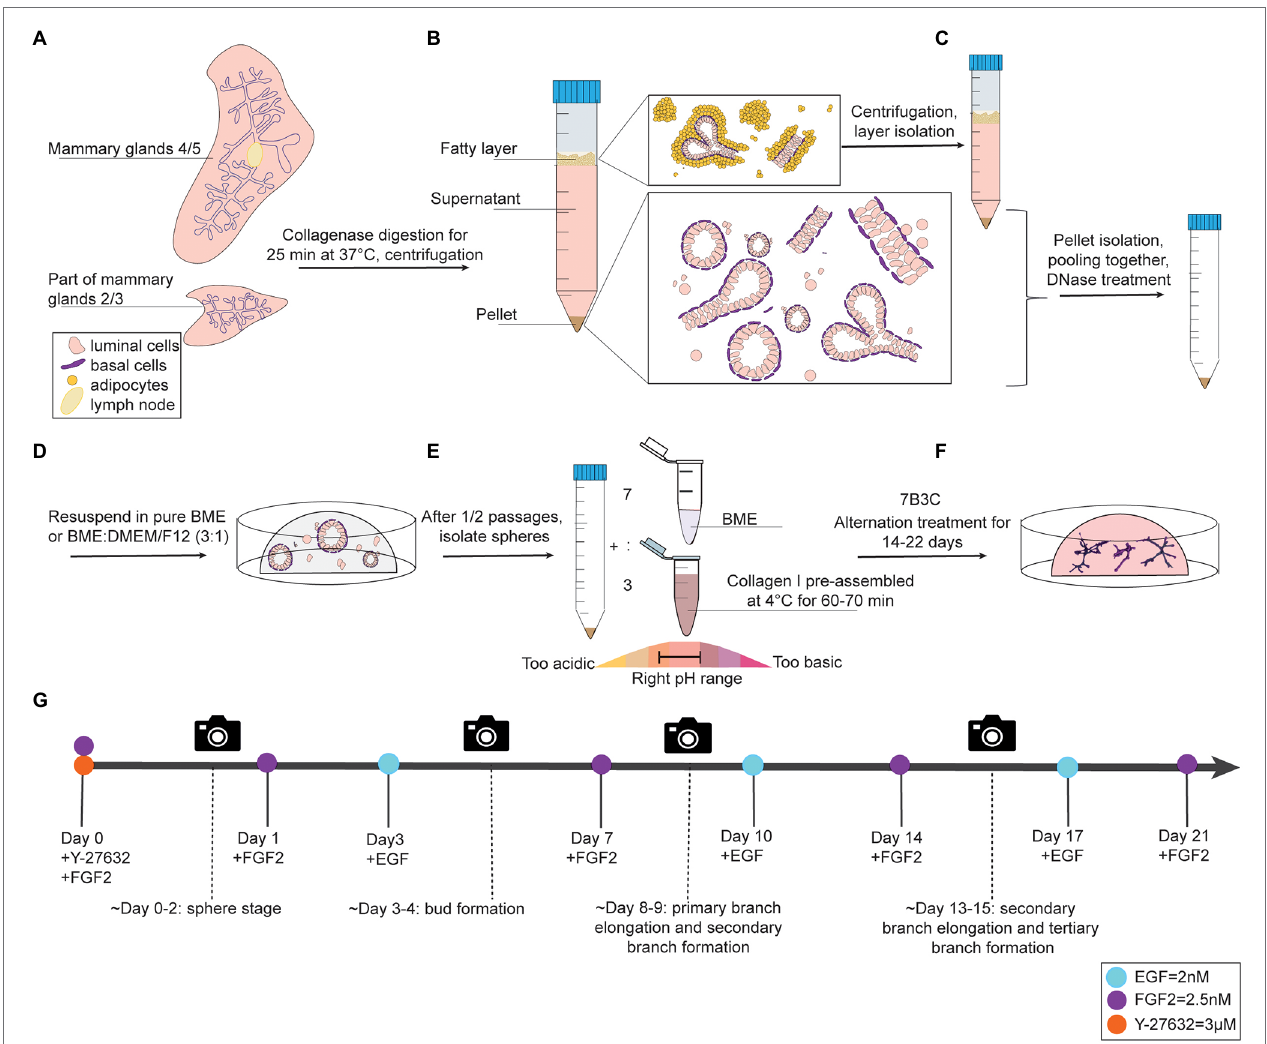
FIGURE 1 | Organoid culture protocol and timeline. (A-C) Dissection, digestion, and centrifugation steps to isolate mammary epithelial fragments for organoid culture. (D) Organoid expansion step in BME to generate mammary spheres. (E) Collagen pre-assembly, pH adjusting step, and generation of BME:collagen I mixture (7:3) to plate mammary spheroids in 7B3C. (F) Alternation treatment with FGF2 and EGF to generate branched mammary organoids. (G) Timeline of mammary gland harvesting procedure and processing steps to obtain branched organoids in 7B3C gels using alternating treatment